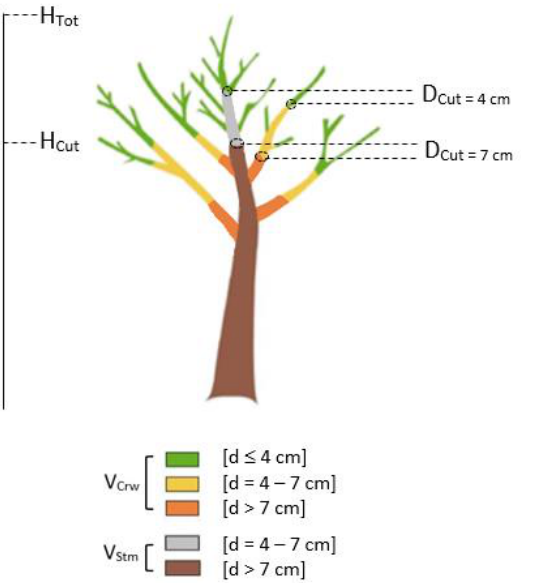
Figure 2. Distribution of tree volume by tree compartment and by diameter classes ([51], modified): H Tot = total height, H Cut = Cutoff height, D Cut = Cutting diameter, V Crw = Crown volume, V Stm = Stem volume.